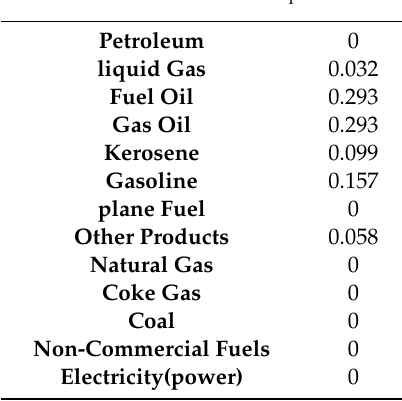
Table A3. Matrix T p .